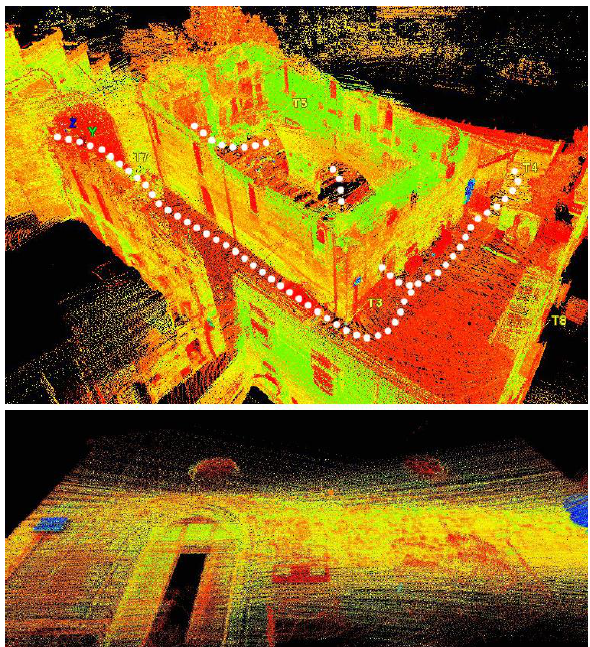
Figure 4 . Mobile Laser Scanner survey and 3D point